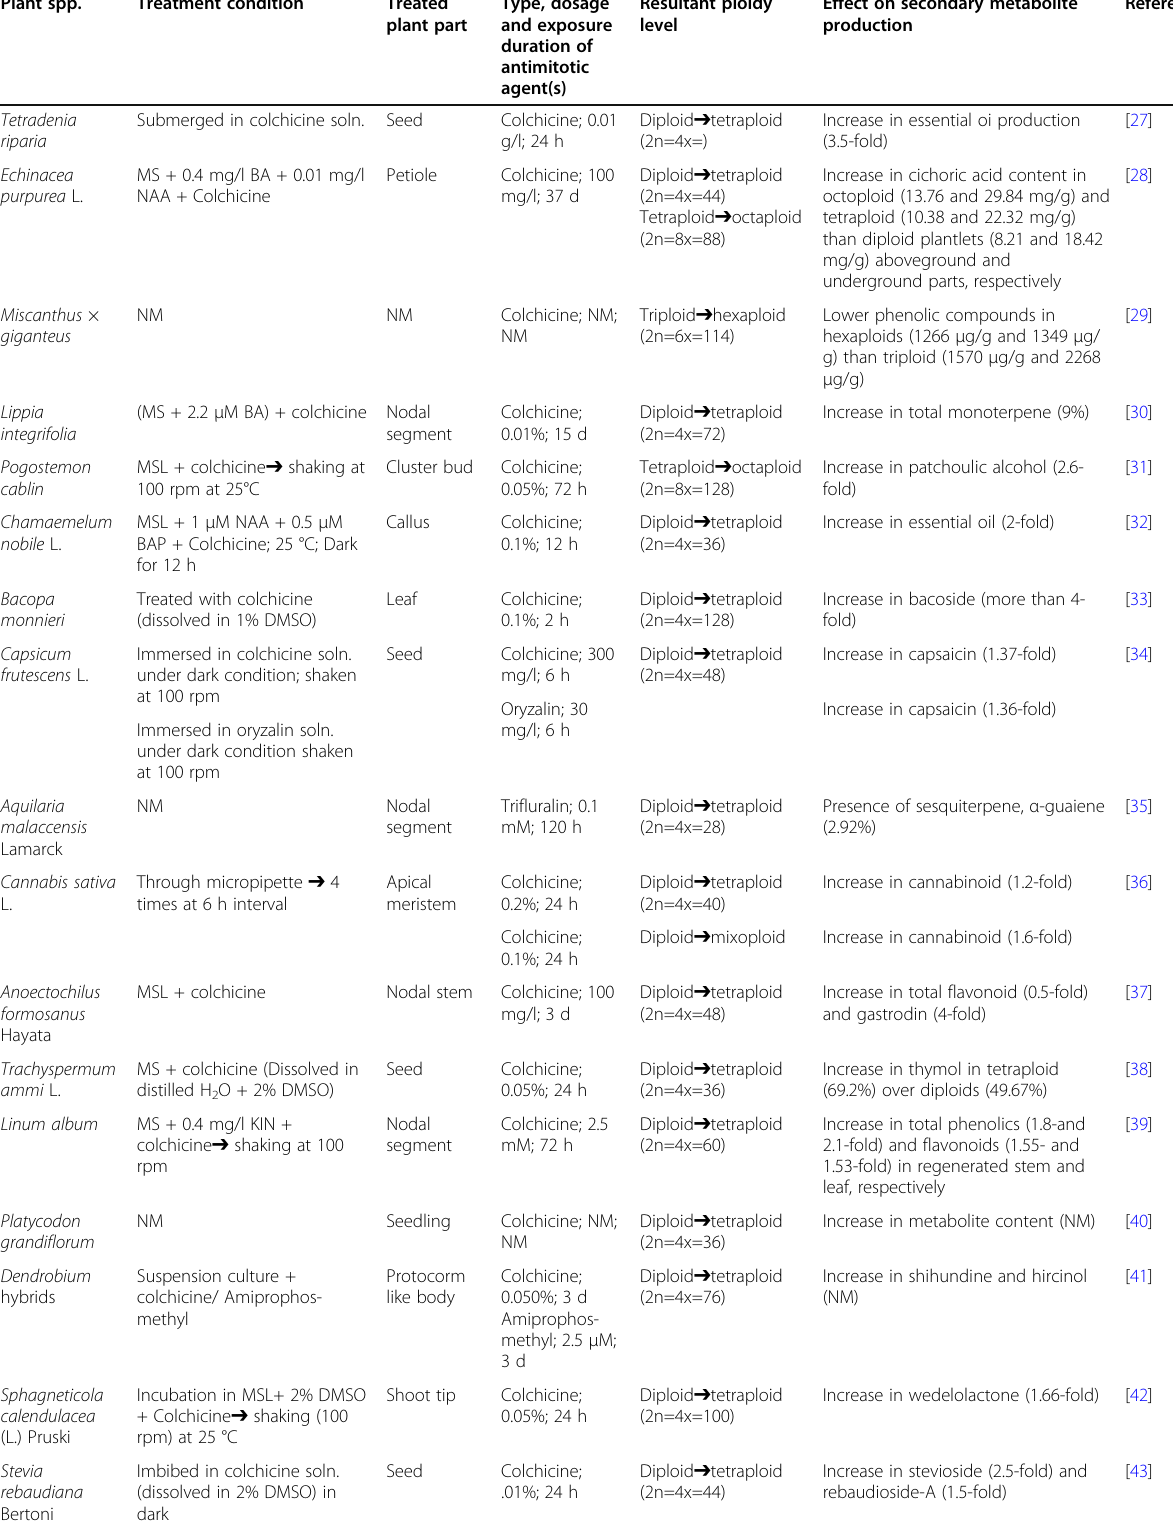
Table 1 Antimitotic agent(s) and their influence on autopolyploidization and subsequent secondary metabolites production (arranged in chronological order) (Continued) Plant